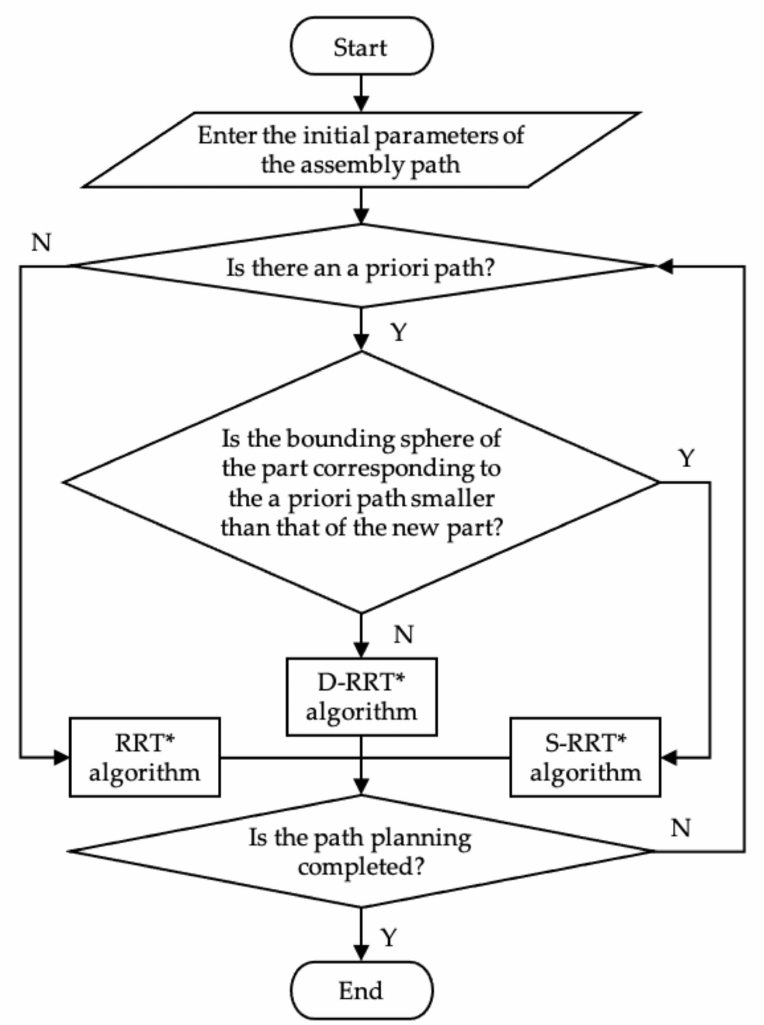
Figure 7. Hybrid process for assembly path